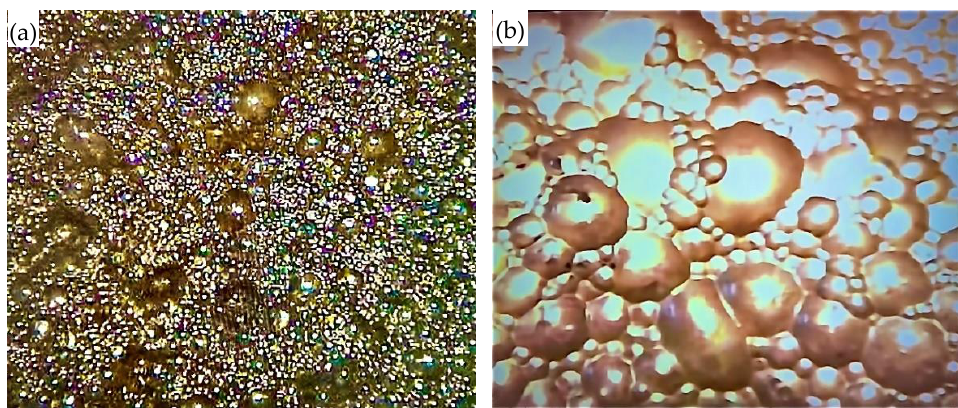
Figure 6. Pyrite vs. copper recovery in flotation after milling conditions of ( a ) Wet-SS ( b ) Wet-MS ( c ) Dry-SS ( d ) Dry-MS.